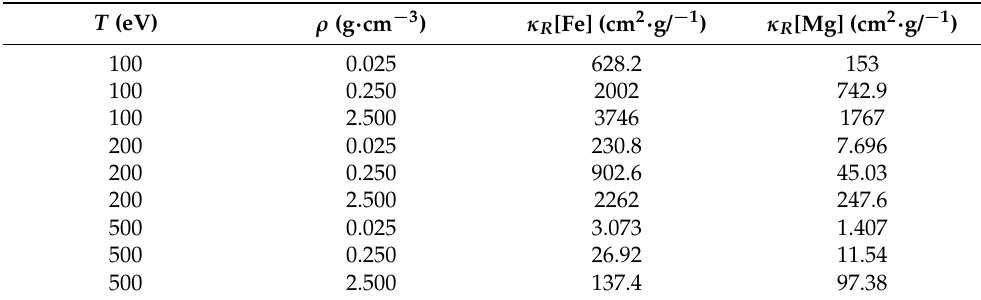
Table 4. Partial Rosseland mean opacities of iron and magnesium for a mixture plasma (number fractions of Fe and Mg are both equal to 0.5) at different temperatures (100, 200, and 500 eV) and densities (0.025, 0.25, and 2.5 g cm − 3 ). These partial densities are obtained by applying the same · electronic pressure to all ions in the plasma [33,34].